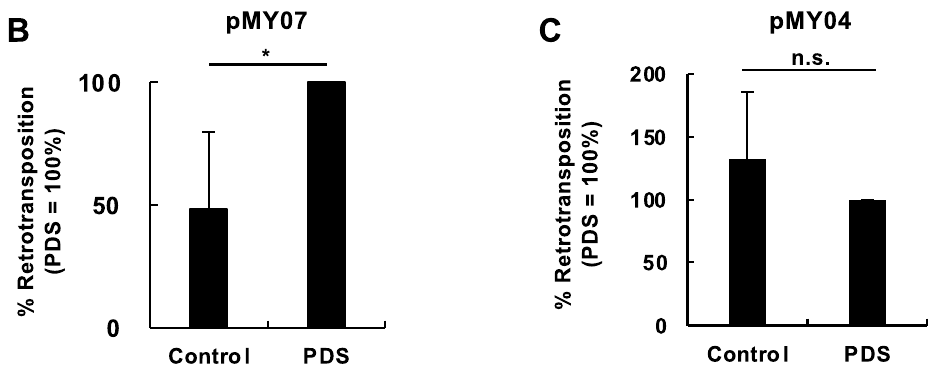
Figure 4. Enhancement of NMR-L1 retrotransposition by PDS. ( A ) Putative G-quadruplex (G4) sequences in the 3 ′ UTR of NMR-L1. The gray boxes indicate G4 sequences with Gs forming G4 structures in bold. ( B , C ) The L1 retrotransposition activity of NMR-L1 with ( B ) or without ( C ) the 3 ′ UTR in the presence of 200 nM PDS. 293T cells were transfected with the indicated L1 reporter plasmids. At 2 days after transfection, PDS was added to the transfected cells at a final concentration of 200 nM. Luciferase activity level in the cells was evaluated at 4 days after transfection. Values are expressed as the means + S.E. of seven independent experiments. *, P < 0.05.